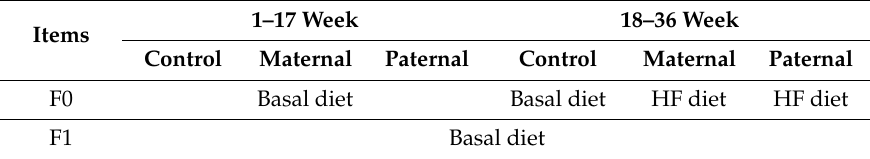
and represent the cock and ♀ ♂